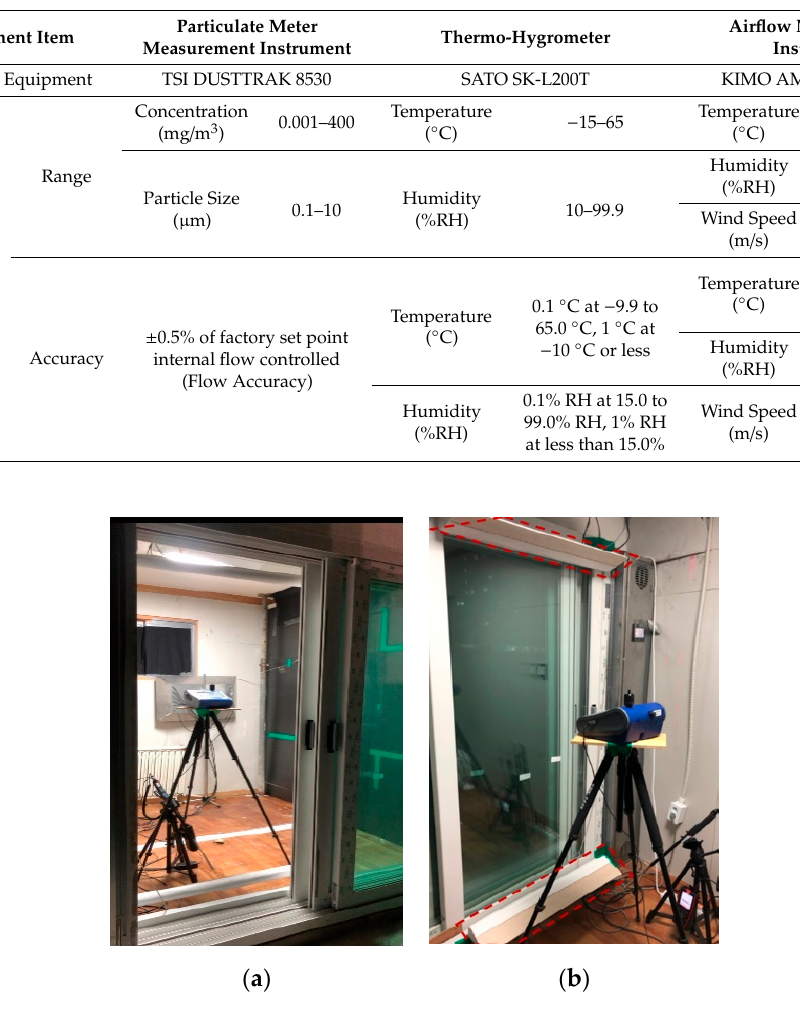
Figure 12. Setup of the mock-up experiment. ( a ) measuring device, ( b ) louver application.